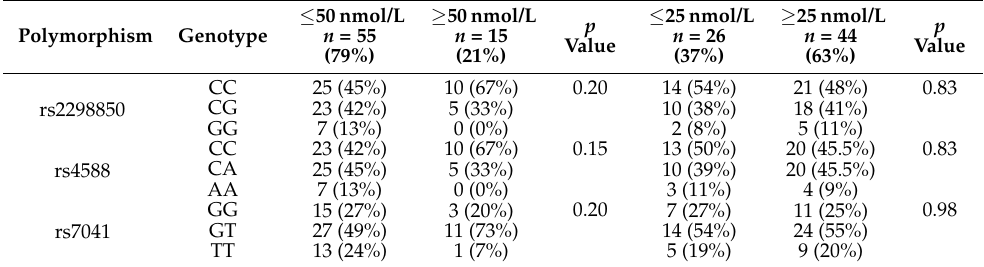
Table 7. Neonatal vitamin D status at birth (cut-offs at birth ≤ 25 vs. ≥ 25 nmol/L and ≤ 50 vs. ≥ 50 nmol/L) according to neonatal VDBP polymorphisms.